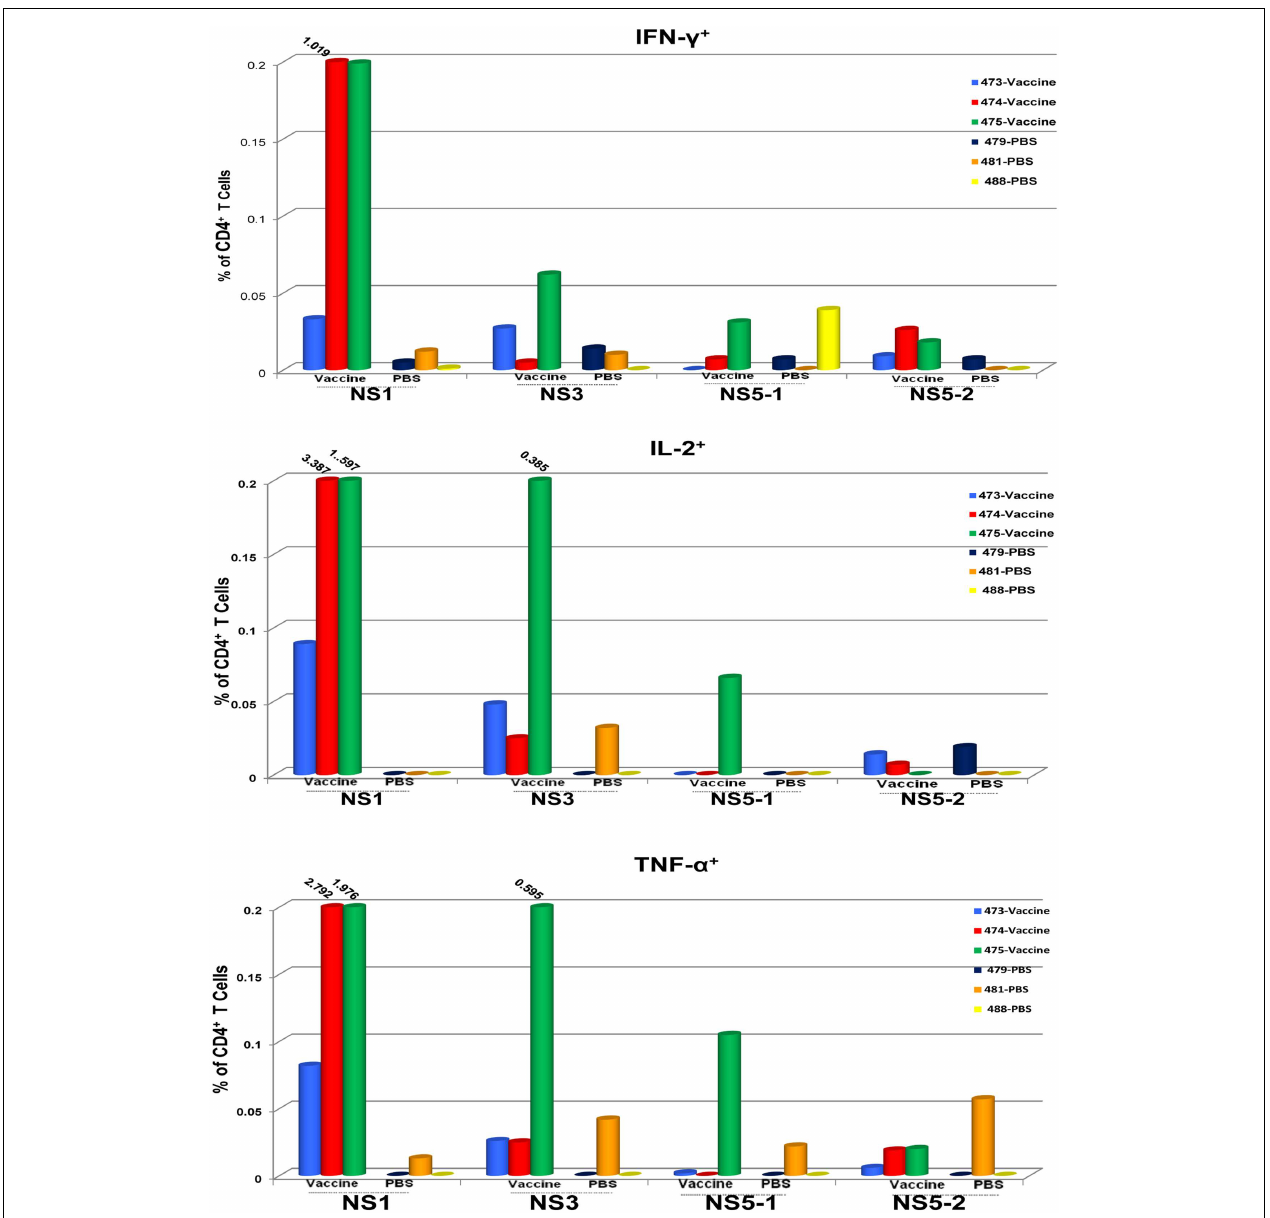
percentage of cytokine-positiveT cells in medium only treated cells subtracted. Peptide arrays for NS5 were split into two pools; NS5-1 and NS5-2. PBMCs from PBS immunized animals were used as